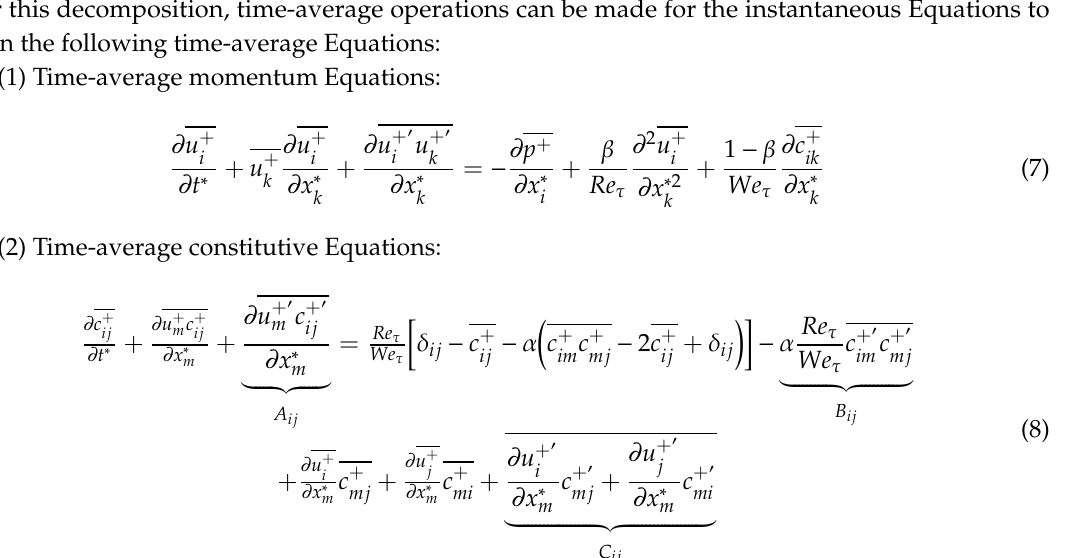
Table 1. Comparison of bulk mean variables.